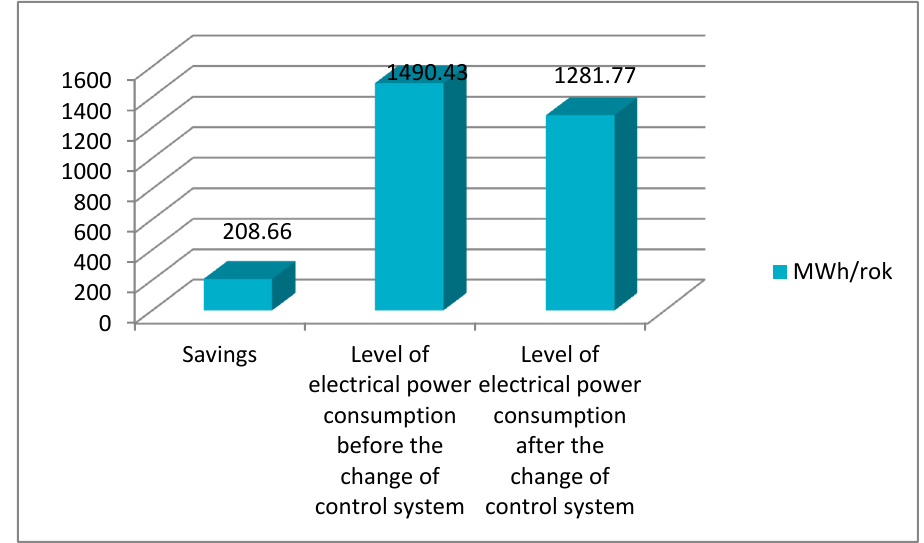
Figure 13. Results of the optimization of aeration process in the bioreactor.